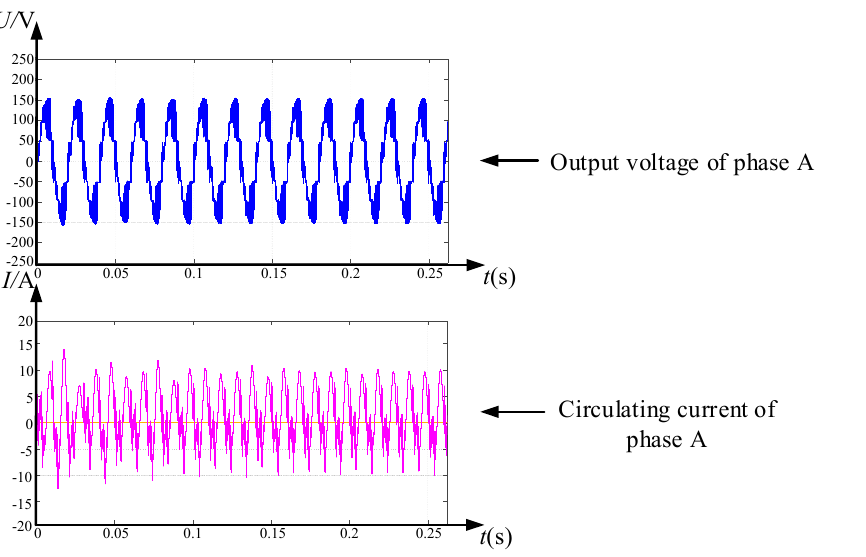
Figure 7. Waveform of the output voltage and the circulating current of phase A when SDA-based CPS modulation is adopted.